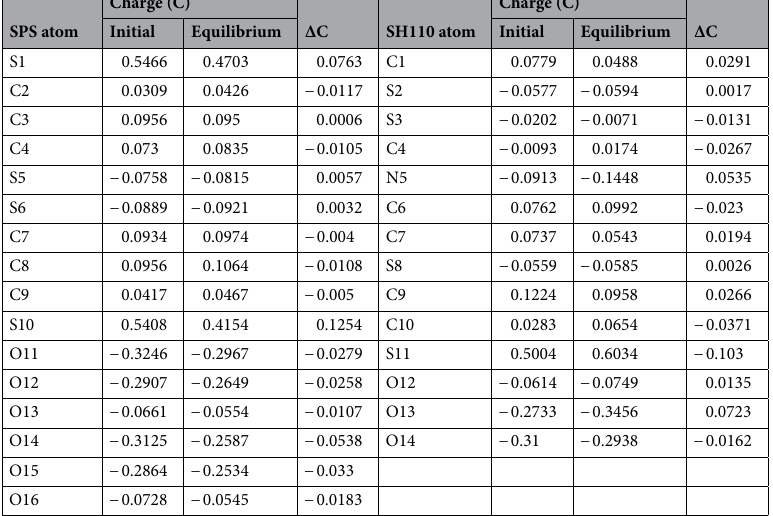
Table 3. Natural atomic charge of SPS and SH110 initially and at